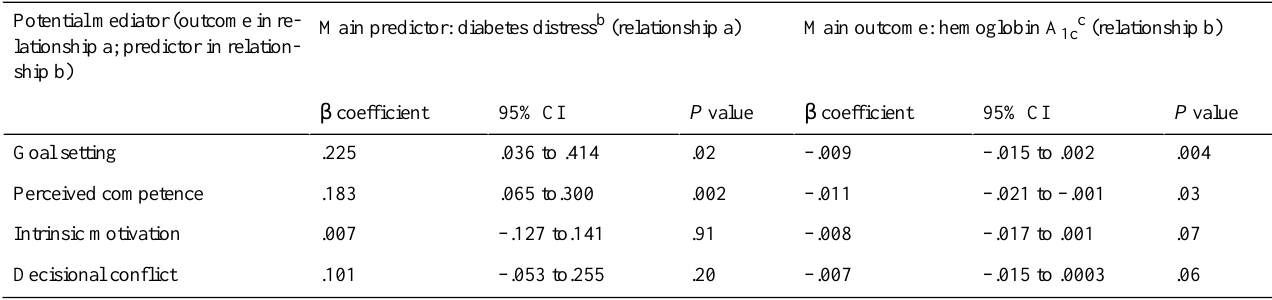
Table 2. Adjusted estimates of the effect of diabetes distress on all potential mediators (relationship a) and the effect of all mediators on hemoglobin A 1c (relationship b). a